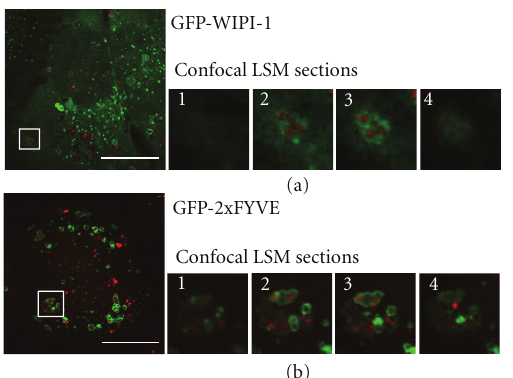
Figure 9: Confocal laser scanning microscopy of S. aureus USA300 infected GFP-WIPI-1 or GFP-2xFYVE expressing U2OS cells. GFP-WIPI- 1 (a) or GFP-2xFYVE (b) expressing U2OS cells were infected with S. aureus USA300 for 2h in DMEM/FCS. Representative images ( n = 3) are shown. Magnifications display individual LSM sections (1–4). Scale bars: 20 μ